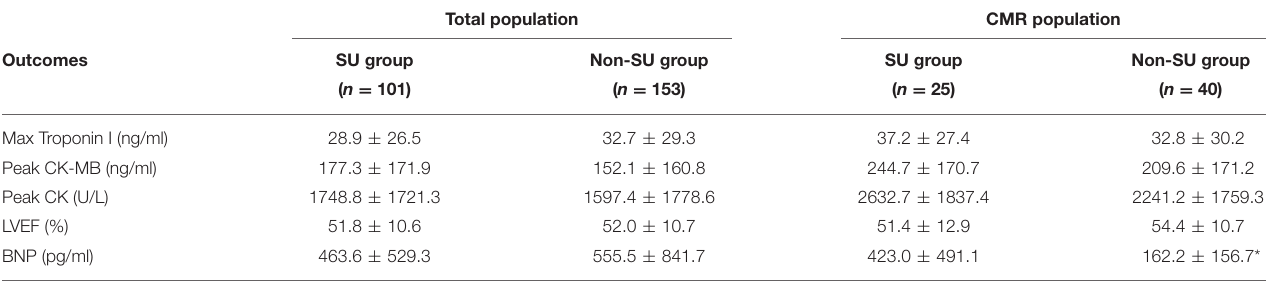
TABLE 2 | Association ofsulfonylurea use with cardiac enzymes and heart failure indexes.